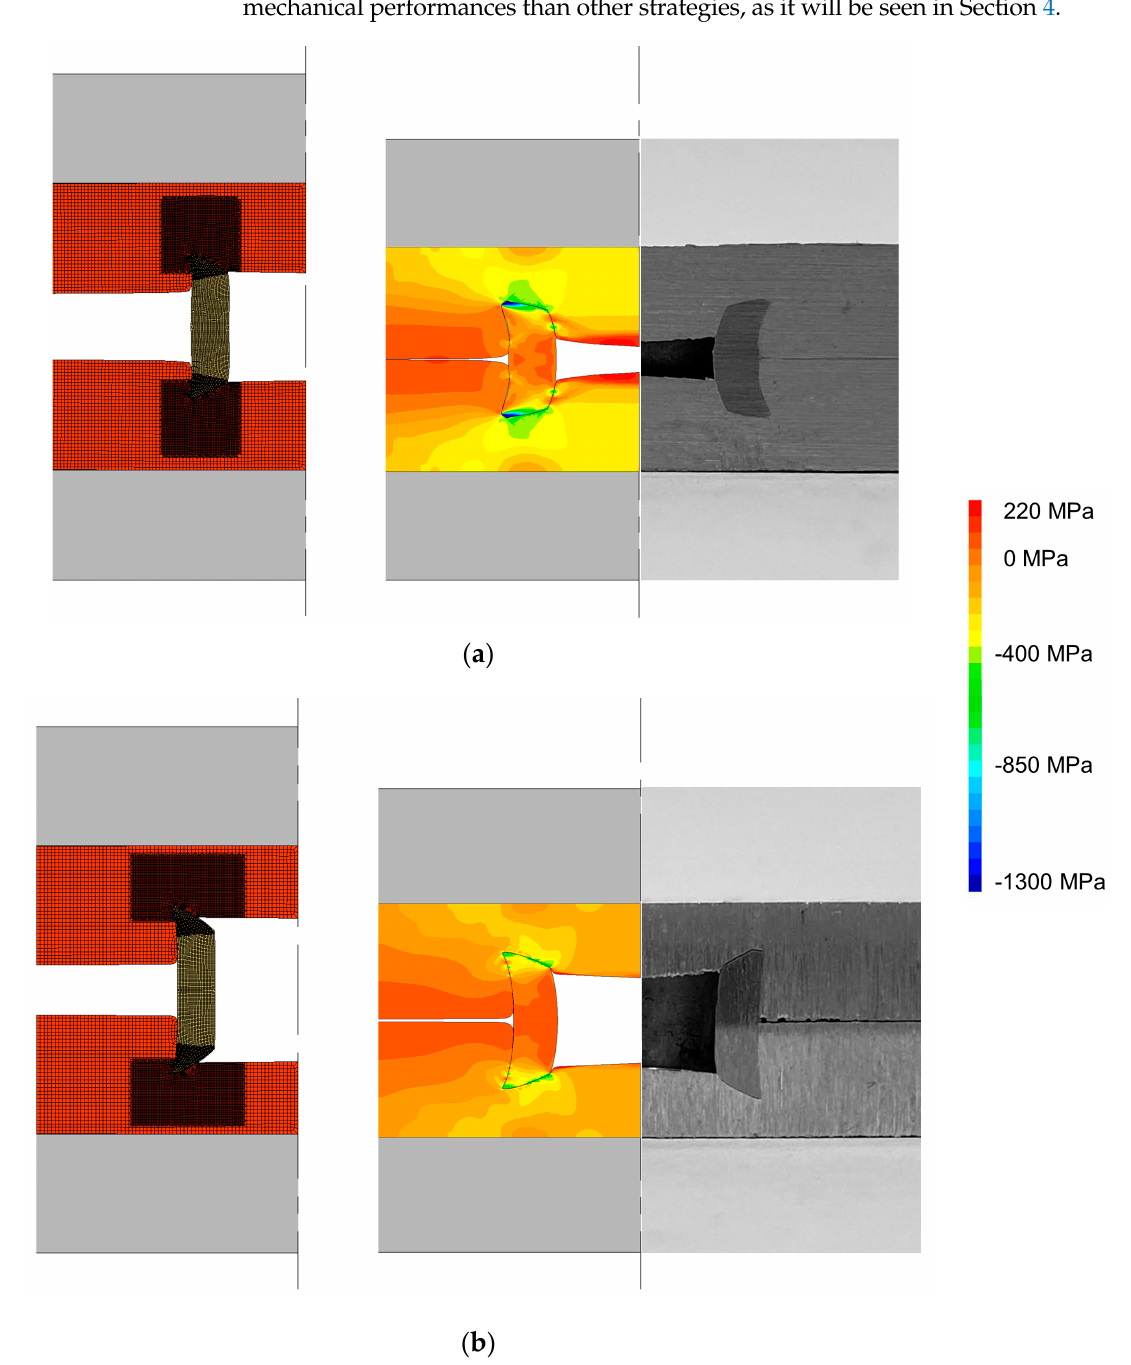
Figure 6. Evolution of DSSPR for sheets with flat-bottom holes with depths d p of ( a ) 1 mm and ( b ) 2 mm. The respective radial stress distribution is presented.